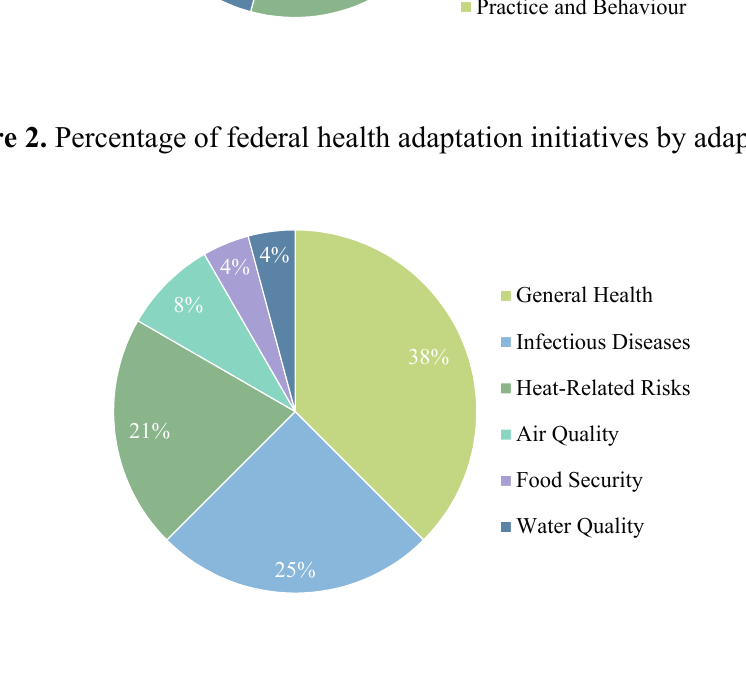
Figure 3. Percentage of federal health adaptation initiatives by health